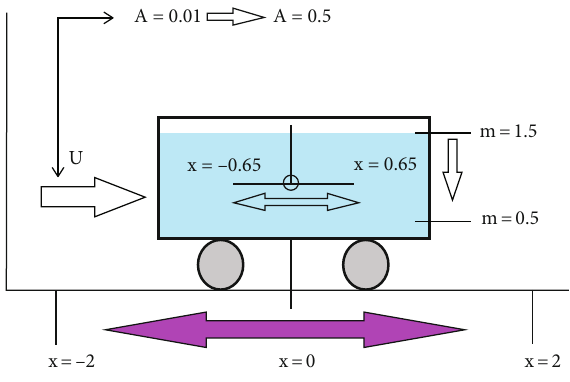
Figure 8: Schematic diagram of a 2D rectangular tank.